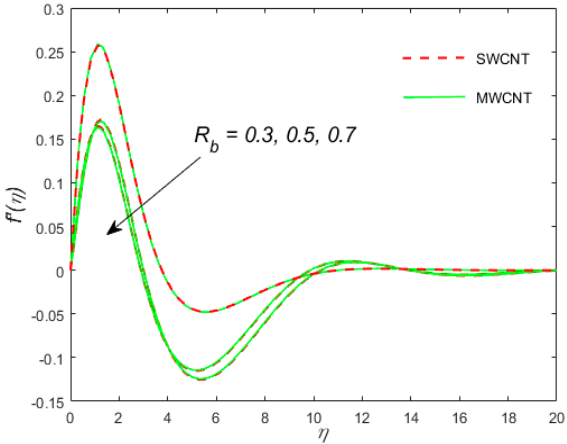
Figure 6. The variation of the velocity distribution profile f’ ( η ) for the case of SWCNT and MWCNT versus the similarity variable for the distinct values of the bio-convection Rayleigh number ( R b ).